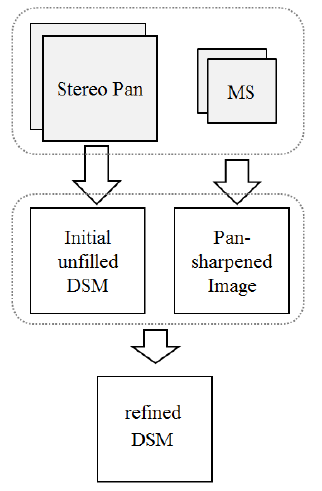
Figure 6. Data preparation; DSM refinement through void filling using spectral information from multispectral